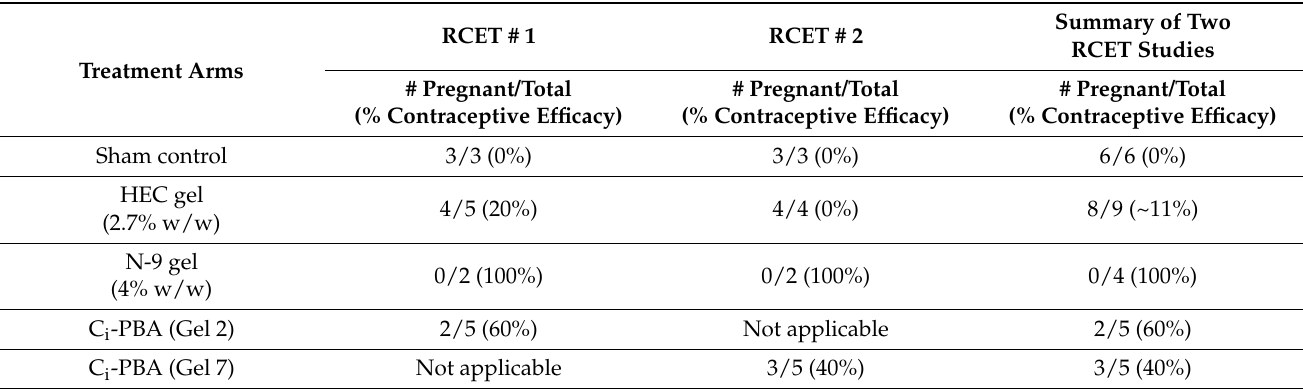
Table 5. Summary of RCET Study Results of Gels (2 mL of each samples